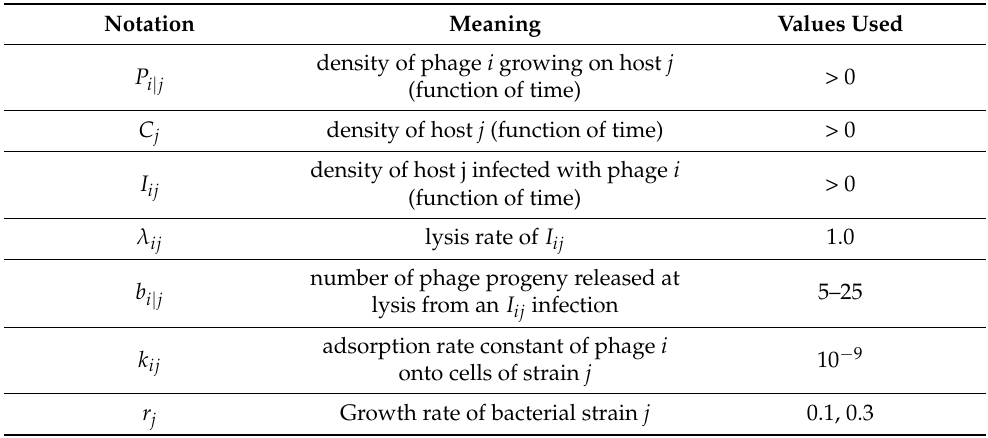
Table 1. Notation used in